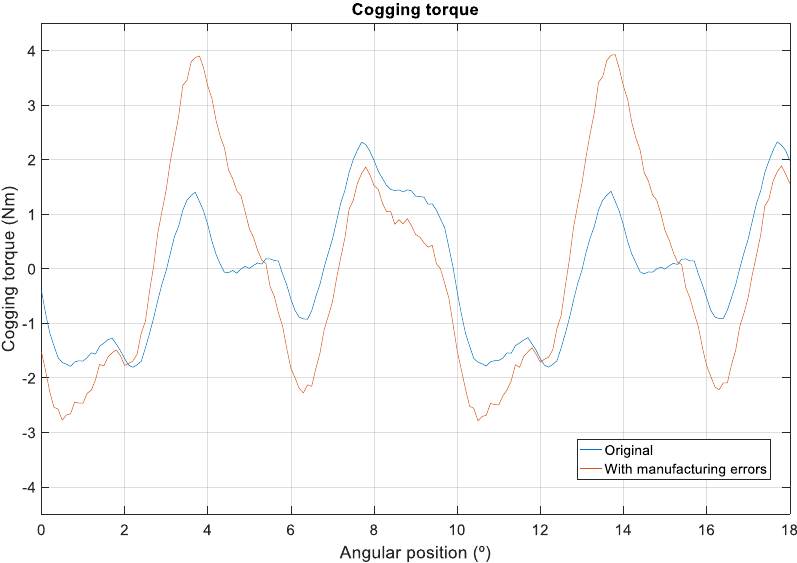
Figure 3. Simulation results of cogging torque of the original model considering manufacturing errors.